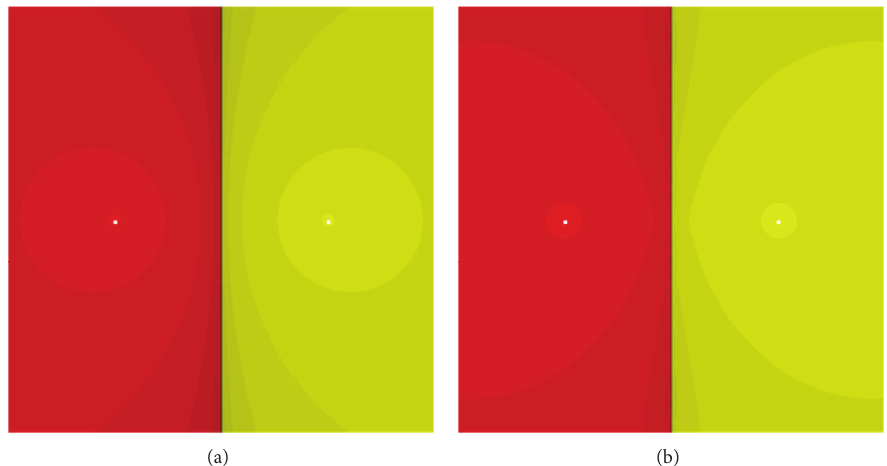
Figure 2: The basins of attraction for (7) (a) and method (23) (b) for the polynomial 𝑥 2 −1 = 0 (shaded by the number of iterations to obtain the